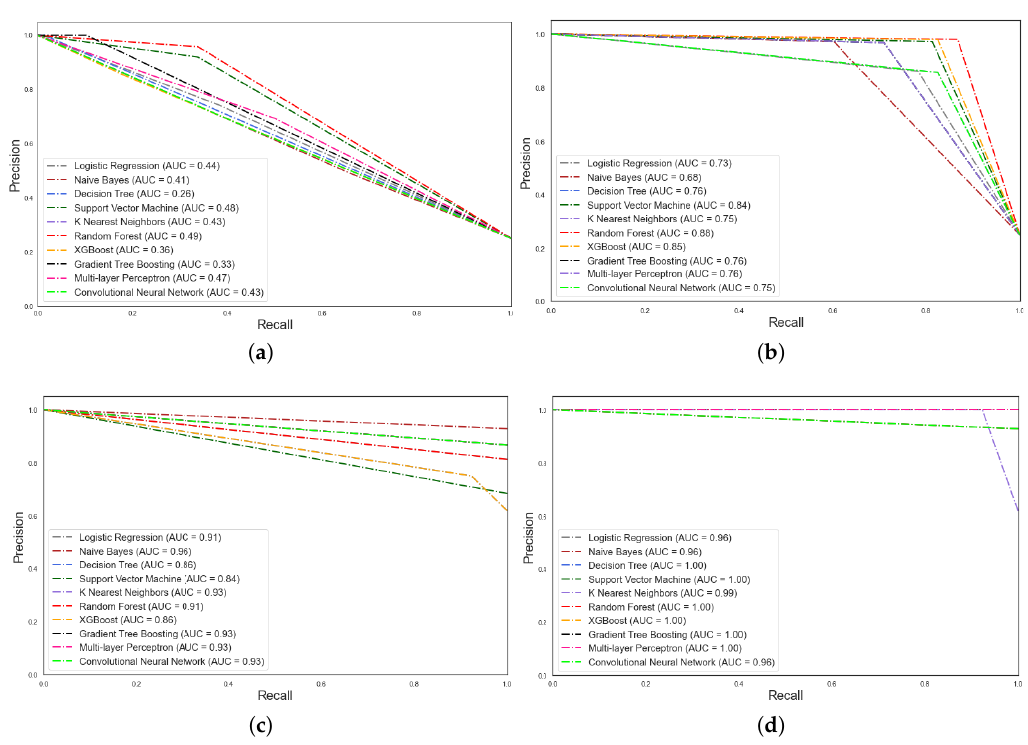
Figure 8. ( a ) Precision-recall curves for multi-class without FC-SMOTE. ( b ) Precision—recall curves for multi-class with FC-SMOTE. ( c ) Precision–recall curves for binary classification without FC-SMOTE. ( d ) Precision–recall curves for binary classification with